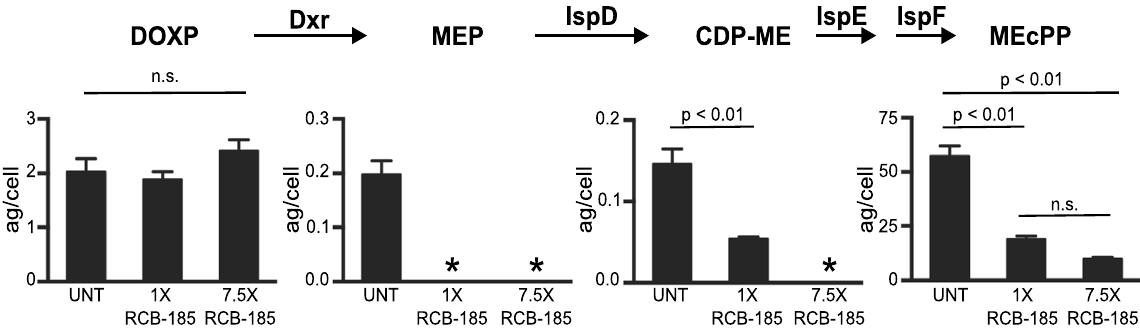
Figure 3. RCB-185 inhibits the MEP pathway in P. falciparum . MEP pathway metabolites were compared between untreated (UNT) P. falciparum and parasites treated with RCB-185 at either 1x or 7.5x the WT IC 50 value of 18.3 nM. After 10 h treatment, cultures were saponin-lysed, and the pellets were analyzed by LC-MS/ MS. Displayed are the means ± SEM of the metabolite levels from 3 independent experiments. No statistically significant difference was denoted by n.s., and asterisks indicate metabolites that were below the limit of detection (CDP-ME below 1.25 ng/mL and MEP below 12.5